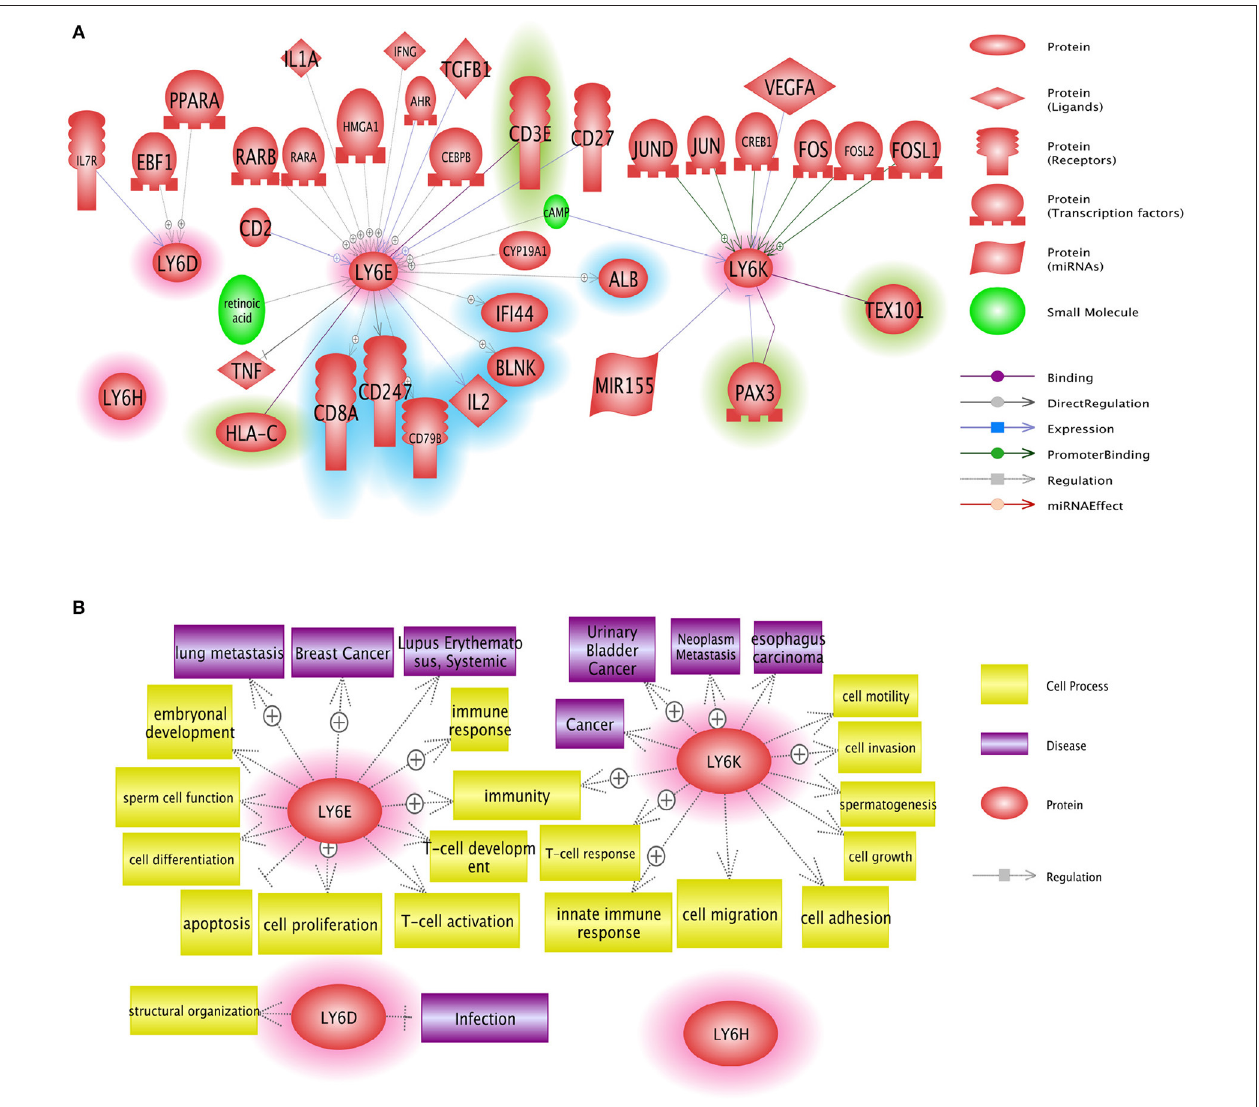
FIGURE 5 | Network analysis of Ly6D, Ly6E, Ly6K, and Ly6H genes. (A) Pathway studio network analysis showed that LY6 signaling is involved in broad range of molecules including growth factor, nuclear receptor, and micro RNAs. The upstream regulators are not highlighted, the downstream effectors are highlighted with blue, and the potential binding partners are highlighted with green. (B) Pathway studio network analysis showed that Ly6 gene family affect multitude of cellular fate and cell-cell interaction with microenvironment ranging from growth, apoptosis, autophagy, immune response ( 37).